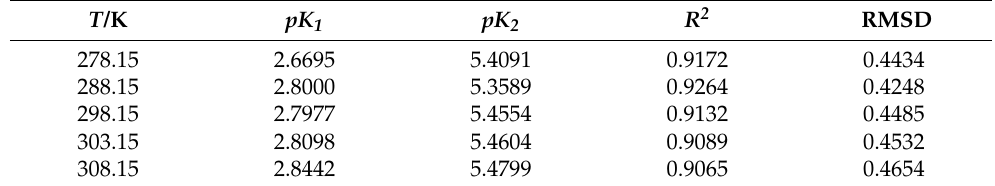
Table 6. Nezhad equation fitting parameters for the solubility of 7-ADCA in water affected by pH.